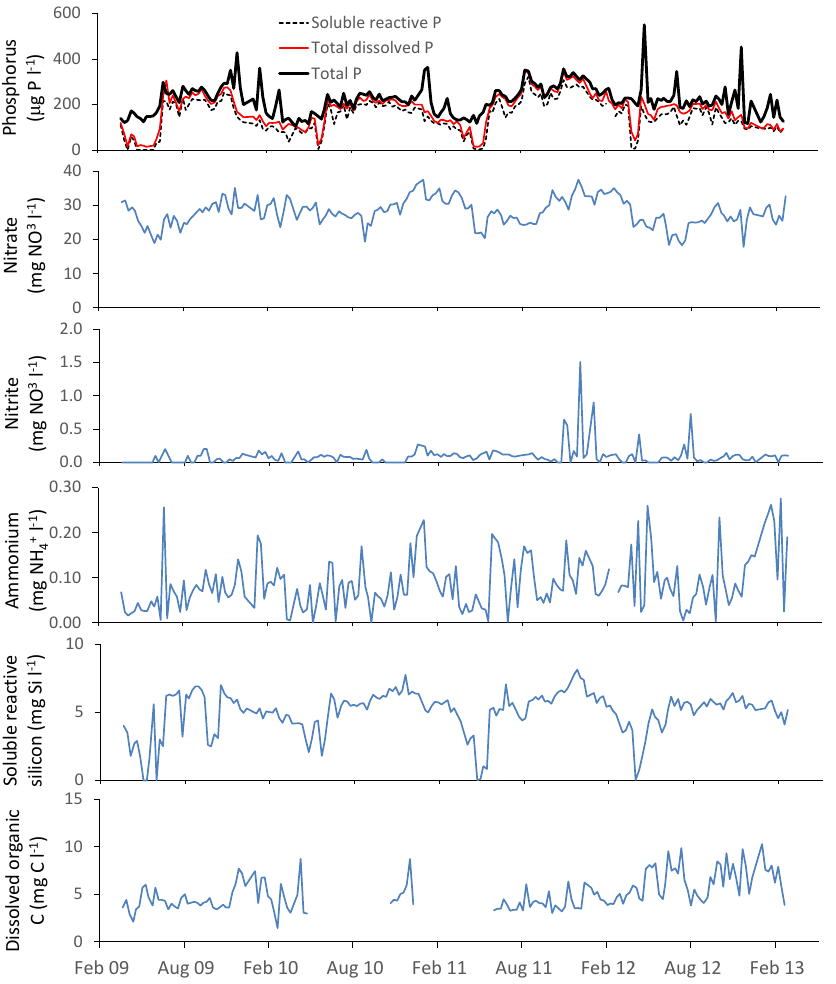
Figure 4. Nutrient concentration time series data for the downstream extent of the monitoring platform (River Thames at Runnymede).